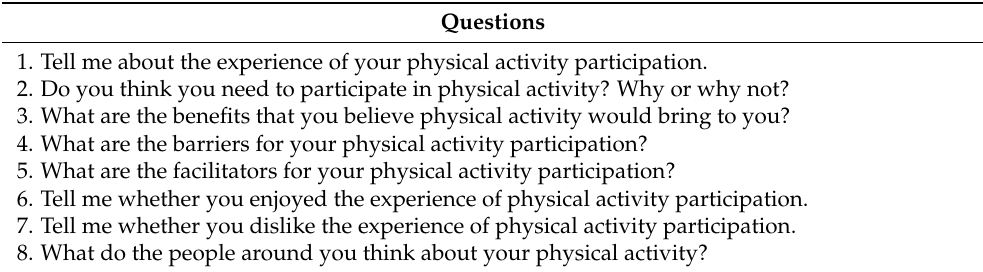
Table 1. Sample questions from the